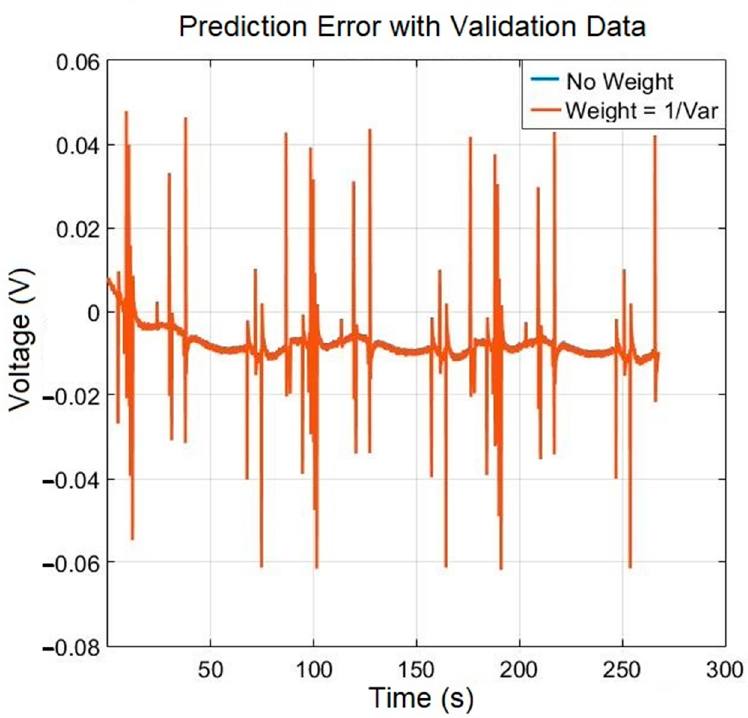
Figure 8. Prediction error regarding battery voltage.